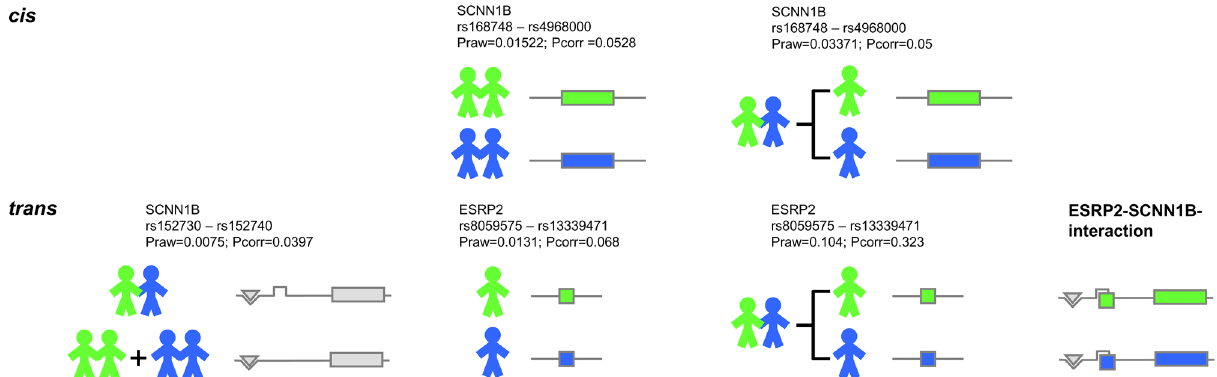
Figure 8. Identifying cis and trans regulatory elements in SCNN1B. Concordant mildly (two siblings who are shown in green), concordant severely (two siblings who are shown in blue) and discordant siblings (pairs composed of one green and one blue colored sib) have been selected from a total of 318 sibling pairs 12 and analyzed in a series of case-reference association studies. Cis : The genomic segment rs168748–rs4968000 determines SCNN1B functionality directly: the observed interpair and matching intrapair association with CF disease severity can be explained by the SCNN1B variants in cis (data not shown). Trans : To explain the association with the discordant phenotype, variants at SCNN1B genomic segment rs152730–rs152740 require an interacting partner encoded in trans to SCNN1B. The genetic variation at ESRP2 contributes to the manifestation of SCNN1B functionality. In this model, binding sites for DNA interacting partners are shown as a triangular groove (for interaction partners shaped as a triangle) and as a square groove (for interaction partners shaped as a square). In the context of this work, ESRP2 is represented by a square and fits into its binding side at the SCNN1B locus. As a consequence, the phenotype of a sib within a discordant pair is shaped by the interaction of ESRP2 and SCNN1B: the allele rs152731-T, associated with intrapair discordance (Tables 1,2), is more vulnerable to ESRP2 (Fig. 6) and its genetic variations (Fig. 5). Functionally divergent ESRP2 alleles, visualized as green and blue squares, thus determine the phenotype of carriers with ESRP2- receptive SCNN1B alleles that are shown with a square groove. These ESRP2-receptive SCNN1B alleles include rs152731-T and are overrepresented among discordant, but rare among concordant pairs. The five displayed association signals correspond to: SCNN1B, rs168748–rs4968000, Praw = 0.01522; Pcorr = 0.0528: interpair comparison of allele distribution between 11 concordant mildly and 10 concordant severely affected sibling pairs (data not shown). SCNN1B, rs168748–rs4968000, Praw = 0.03371; Pcorr = 0.05: intrapair comparison of allele distribution between mildly affected siblings and severely affected siblings from discordant pairs (data not shown). SCNN1B, rs152730–rs152740, Praw = 0.0075; Pcorr = 0.0397: interpair comparison of allele distribution between 14 discordant sibling pairs and 21 concordant sibling pairs (see Fig. 1B). ESRP2, rs8059575– rs13339471, Praw = 0.0131; Pcorr = 0.068: comparison of allele distribution of unrelated patients stratified for the response of the nasal epithelium upon superfusion with amiloride assessed by nasal potential difference measurement (see Fig. 5). ESRP2, rs8059575–rs13339471, Praw = 0.104; Pcorr = 0.323: intrapair comparison of allele distribution between mildly affected siblings and severely affected siblings from discordant